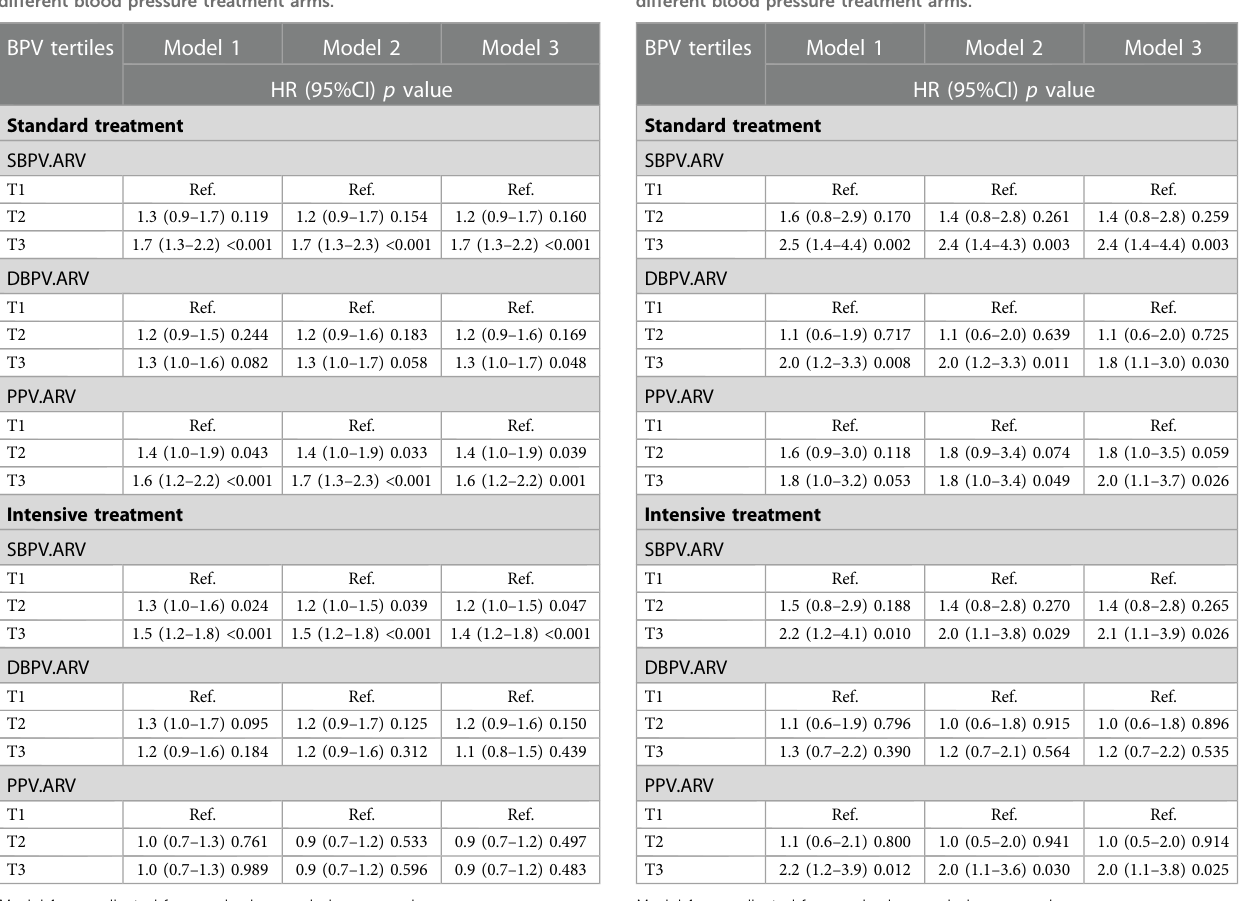
Model 1 was adjusted for age, body mass index, sex and race. Model 2 was adjusted for age, body mass index, sex, race, smoke, estimated glomerular fi ltration rate, Framingham 10-year cardiovascular disease risk score, subclinical cardiovascular disease and total cholesterol. Model 3 was adjusted for age, body mass index, sex, race, smoke, estimated glomerular fi ltration rate, Framingham 10-year cardiovascular disease risk score, subclinical cardiovascular disease, total cholesterol and visit-to-visit mean systolic blood pressure or diastolic blood pressure or pulse